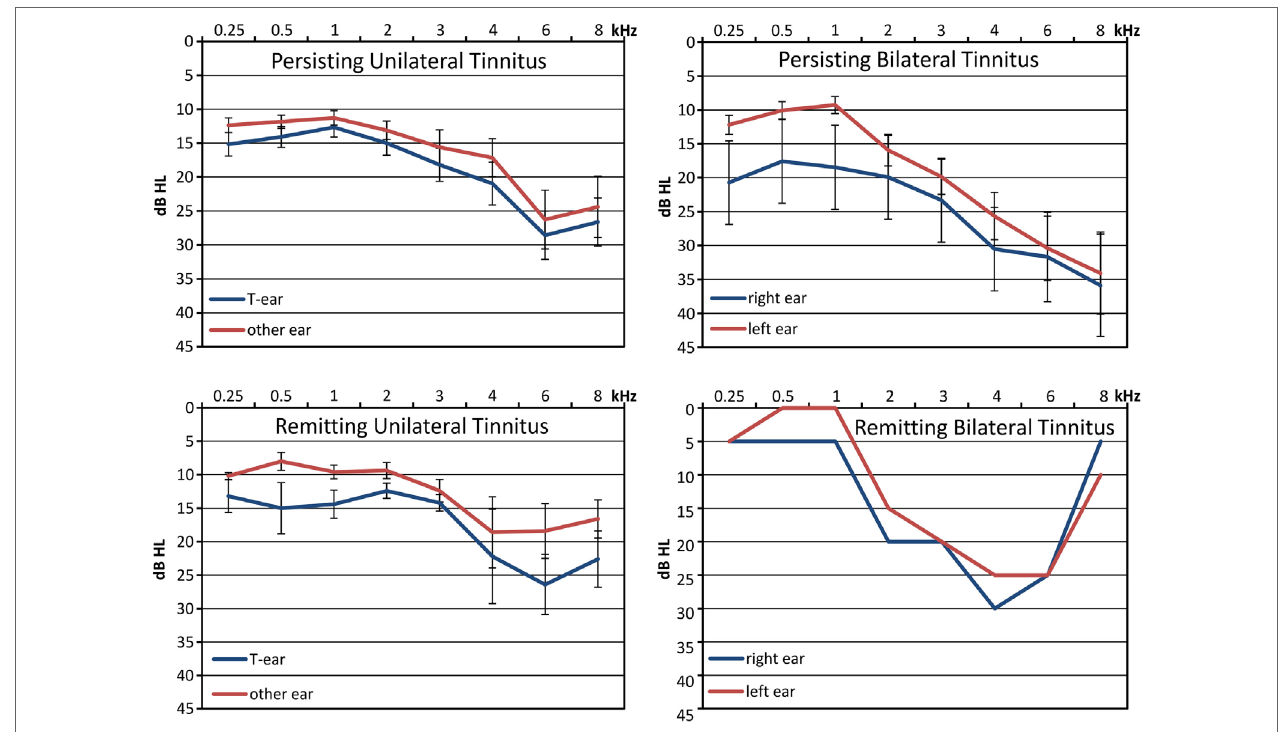
FigUre 1 | Pure Tone Audiograms for groups with persisting and remitting, unilateral and bilateral tinnitus: shown are means with respective standard errors. Unilateral tinnitus: tinnitus heard from one ear, bilateral tinnitus: tinnitus heard on both ears or within the head. An audiogram was not available from one individual with persisting unilateral tinnitus and from another one with persisting bilateral